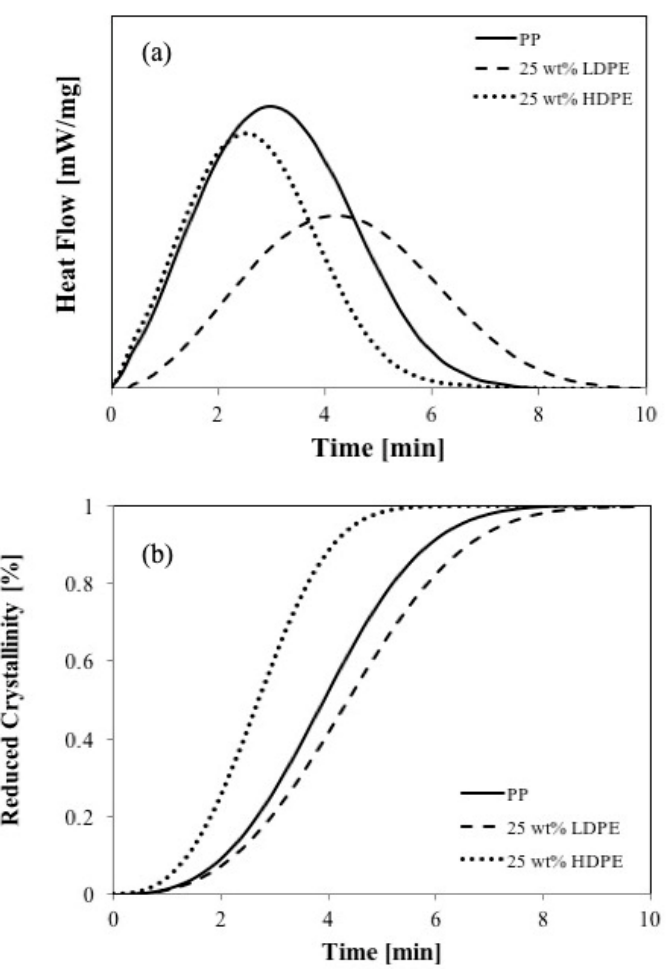
Figure 7. ( a ) Di ff erential scanning calorimetry (DSC) crystallization curves and ( b ) reduced crystallinity Figure 7. ( a ) Differential scanning calorimetry (DSC) crystallization curves and ( b ) reduced obtained at 125 ◦ C for PP (solid line), PP / LDPE containing 25 wt % of LDPE (dash line) and PP / HDPE blends containing 25 wt % of HDPE (dot crystallinity obtained at 125 °C for PP (solid line), PP/LDPE containing 25 wt % of LDPE (dash line) and PP/HDPE blends containing 25 wt % of HDPE (dot line). Table 1. Avrami index ( n ), overall crystallization rate constant ( k ), and crystallization half-time obtained during isothermal crystallization of PP, LDPE, HDPE and their blend at isothermal crystallization temperatures (125 °C) at the cooling rate of 25 K/min.